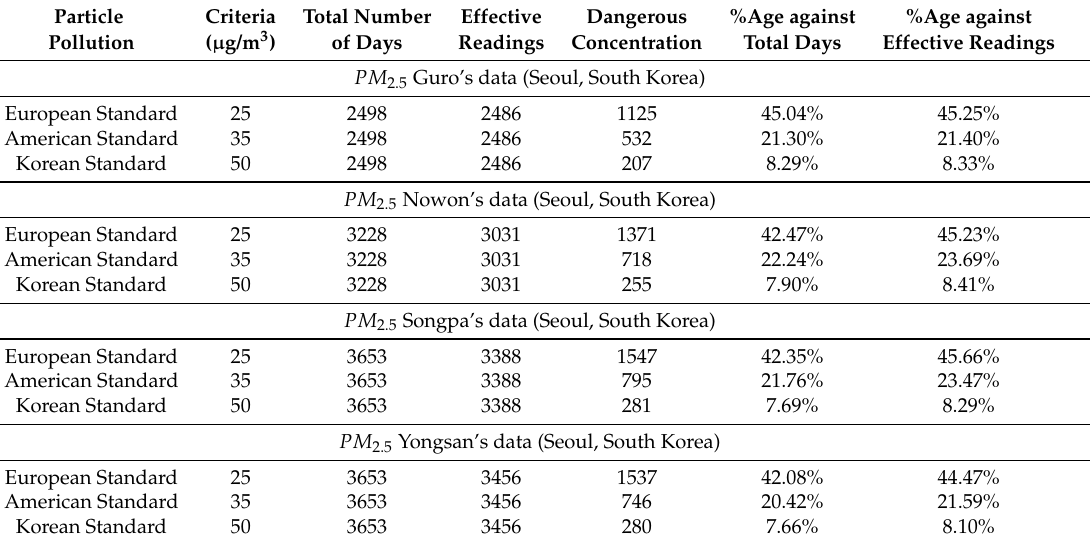
Table 5. Particulate matter ( PM 2.5 ) location-wise